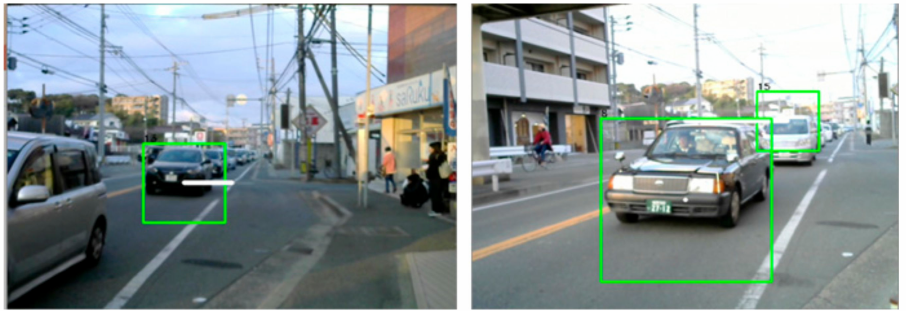
Figure 6. Captured windows in the prototype system. The recognized pixel areas and the di ff erentiated pixels from the center pixel are used for the calculations of the distance and the angle for the AAA